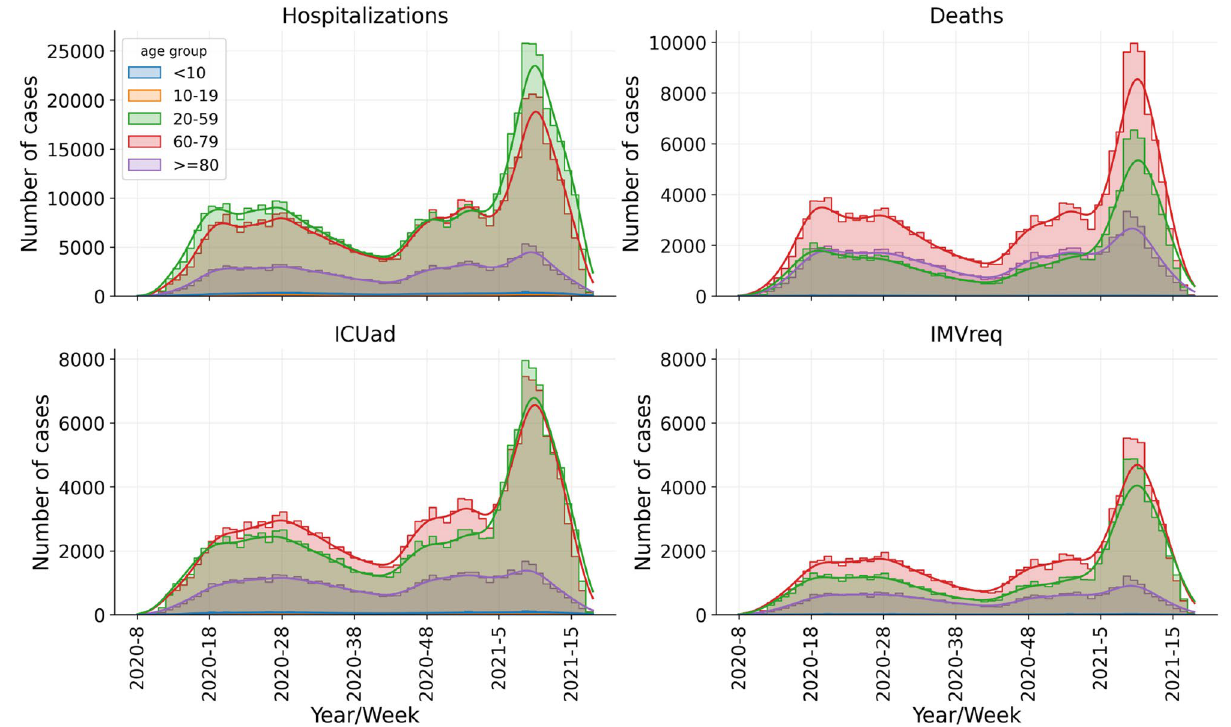
Figure 1. Time series of confirmed cases for hospitalizations, deaths, ICU admission and IMV requirement in Brazil. The horizontal axis (x-axis) refers to the epidemiological weeks according to the onset of symptoms. Timeline was divided into six periods of 10 weeks each, from epidemiological week 2020-8 to